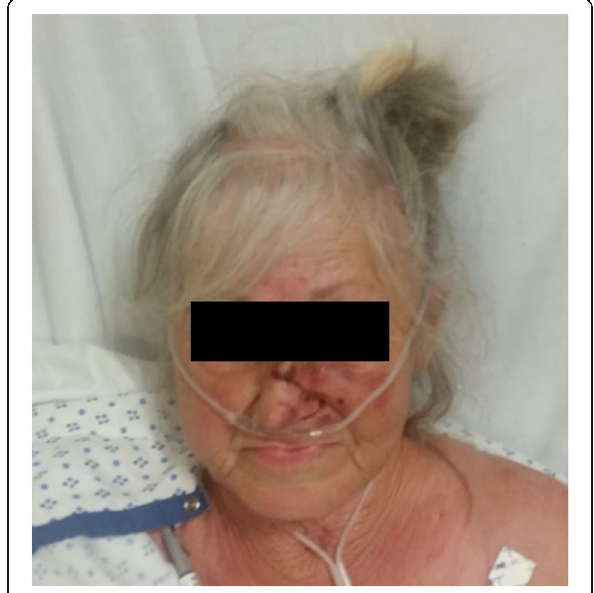
Fig. 3 The patient ’ s appearance after extubation on post